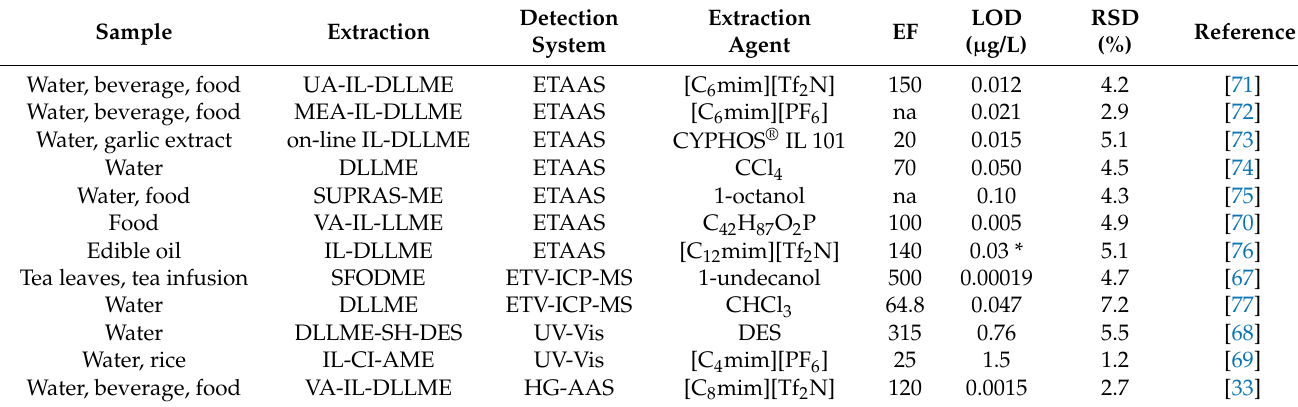
Table 2. Comparison of some analytical characteristics of several liquid microextraction methods proposed for Se(IV) separation and preconcentration and of methods for spectrometric quantification of this